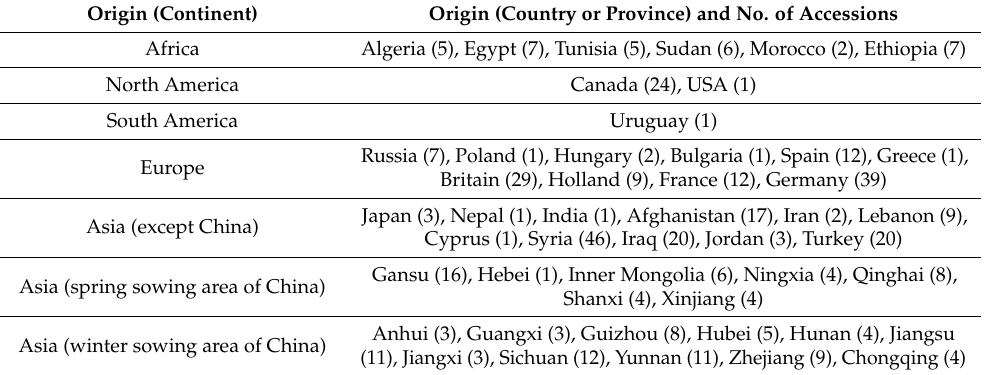
Table 1. Geographic origins of 410 faba bean